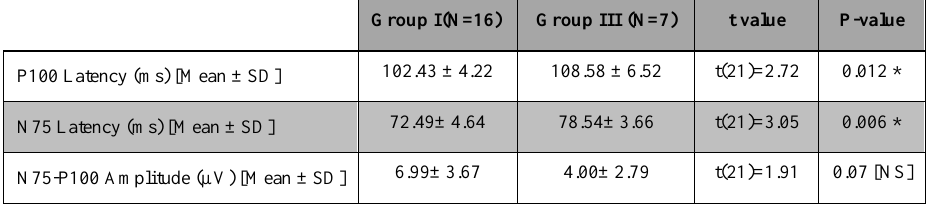
Table 14. Comparison of average VEP wave latencies and the average amplitude of both eyes between group I (having disease duration < 6 years) and group III (having disease duration ≥ 11 years) diabetic patients.